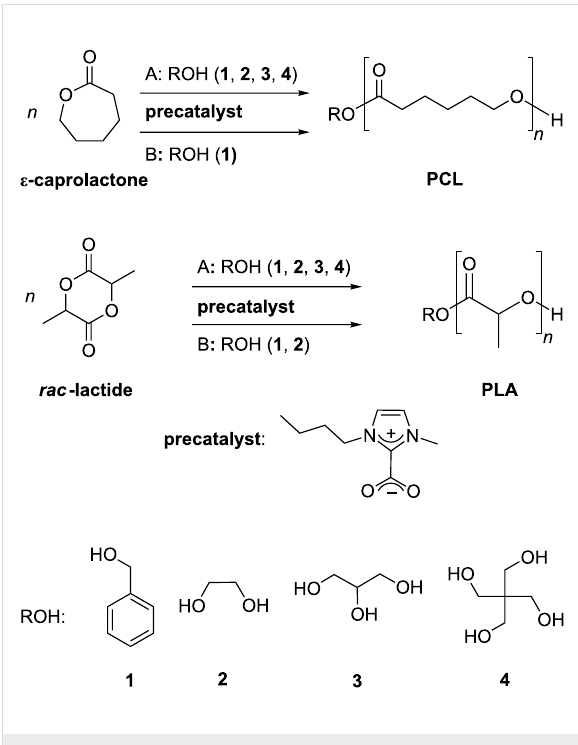
Scheme 1: Ring-opening polymerization of ε -caprolactone and rac - lactide by using BMIM-2-CO 2 as precatalyst (1 mol %), and in the presence of alcohol initiators ROH ( 1 , 2 , 3 , 4 ). Method A: solvent-free conditions , in vacuo, 75 °C, 75 min; method B: solvent-free